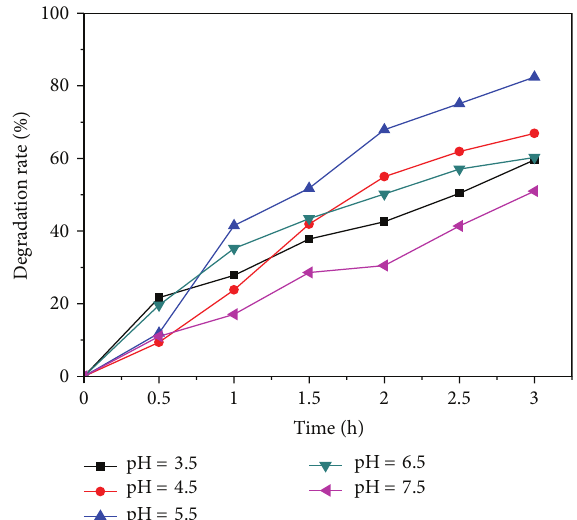
Figure 5: Effect of the solution pH on the photocatalytic degrada- tion rate of methyl violet.